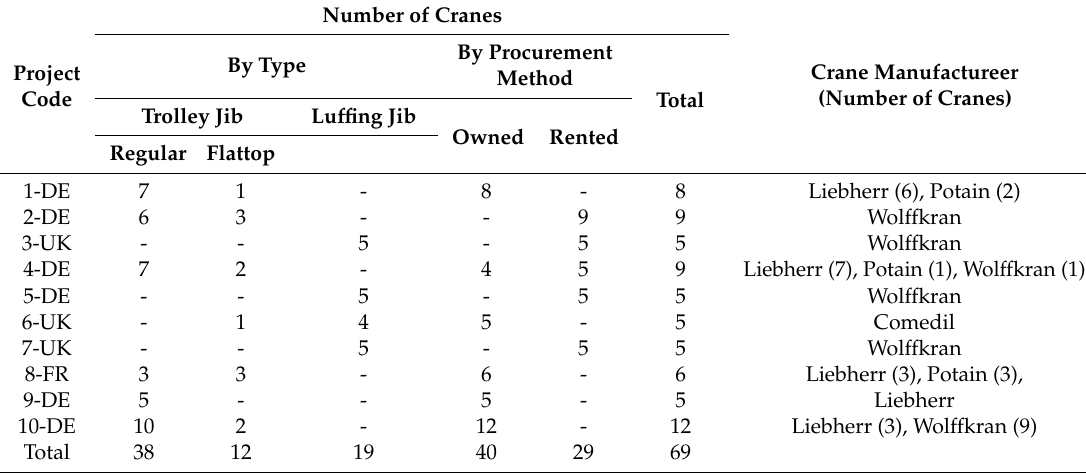
Table 2. Profile of tower